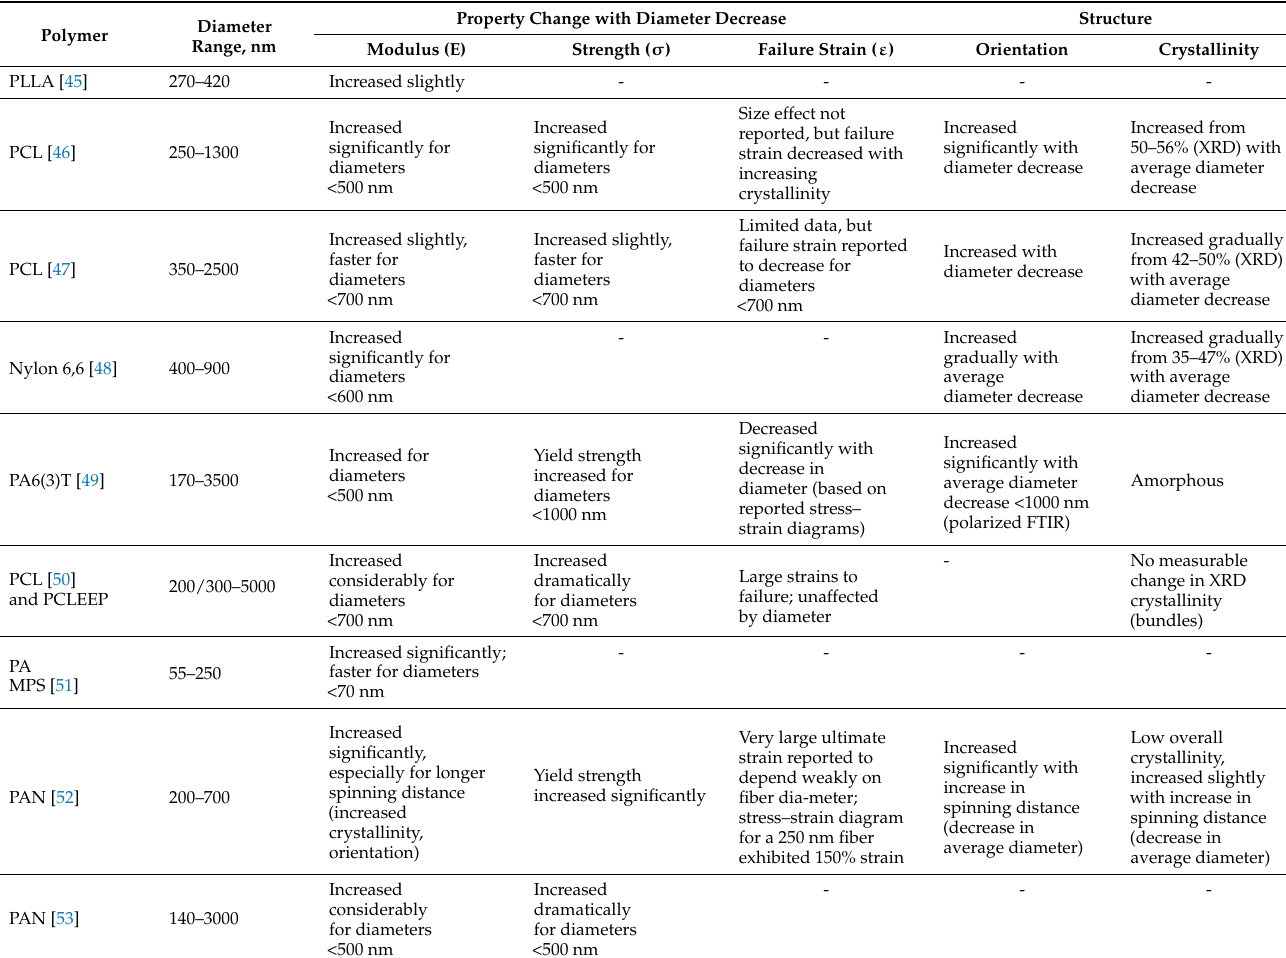
Table 1. Reported size effects in individual electrospun polymer